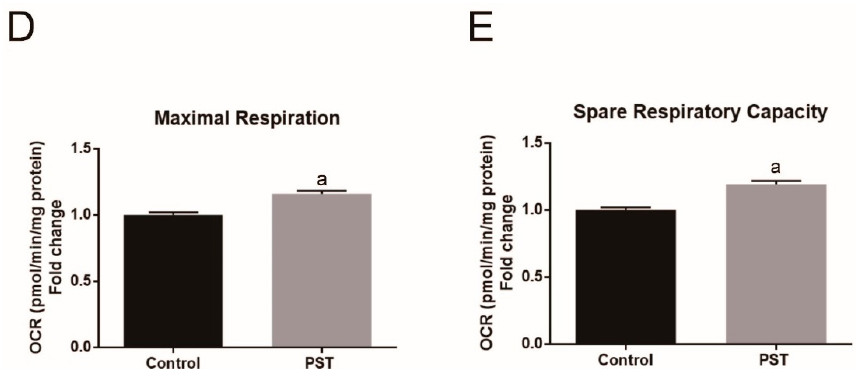
Figure 7. Effects of pterostilbene (PST) treatment on mitochondrial function in C2C12 myotubes. Oxygen consumption rate of C2C12 myotubes treated without or with 1 μ M PST ( A ). The data obtained in panel A were used to calculate the basal respiration ( B ), ATP production ( C ), maximal respiration ( D ) and spare respiratory capacity ( E ). Data are expressed as mean ± SD and analyzed via Student’s t -test, a— p < 0.05.